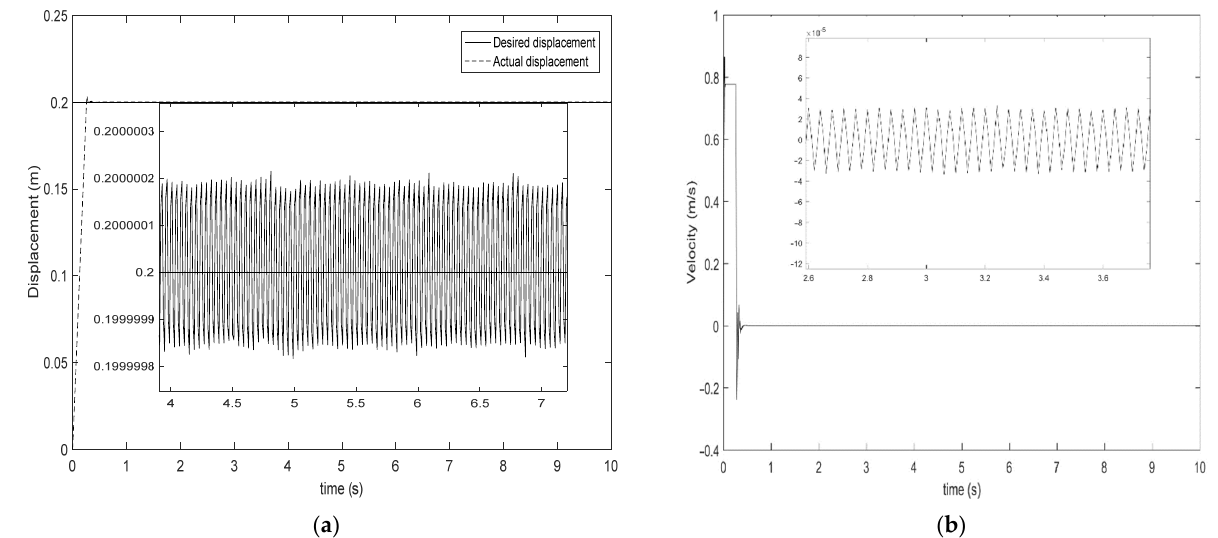
Figure 10. Tracking trajectory of SMC algorithm using adaptive reaching law. ( a ) Displacement buffeting curve and ( b ) velocity buffeting curve.